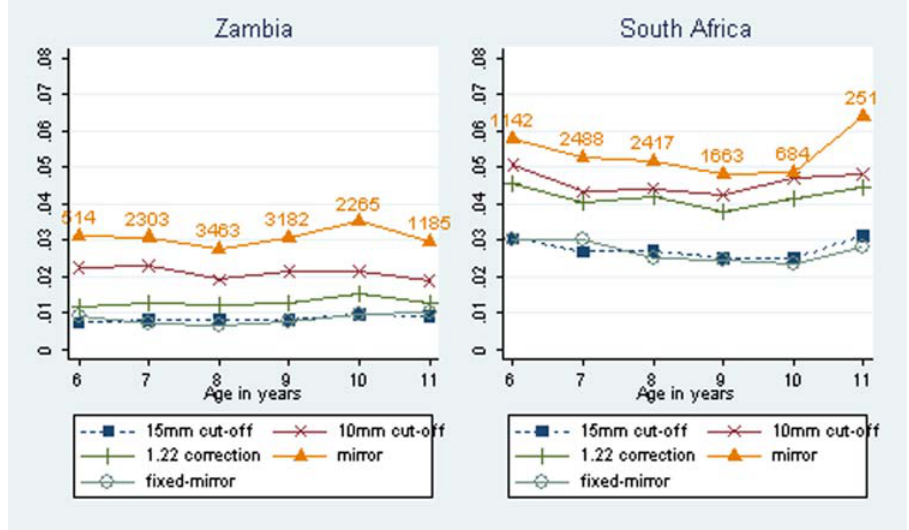
Figure 2. Annual risk of tuberculous infection, as calculated using five methods, by country and age.